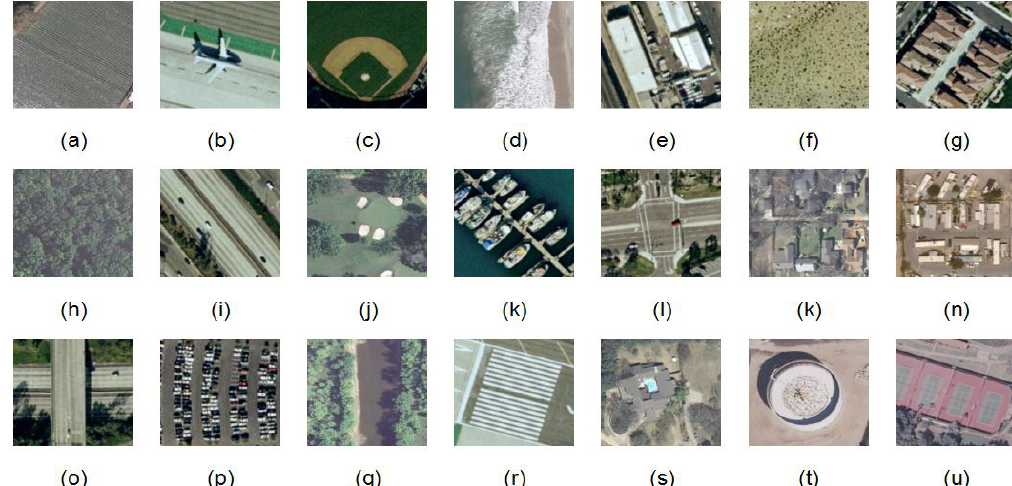
Figure 3. Some category examples from the UC Merced dataset: (a)agriculture, (b)airplane, (c)baseballdiamond, (d)beach, (e)buildings, (f)chaparral, (g)denseresidential, (h)forest,(i)freeway, (j)golfcourse, (k)harbor, (l)intersection, (m)mediumresidential,